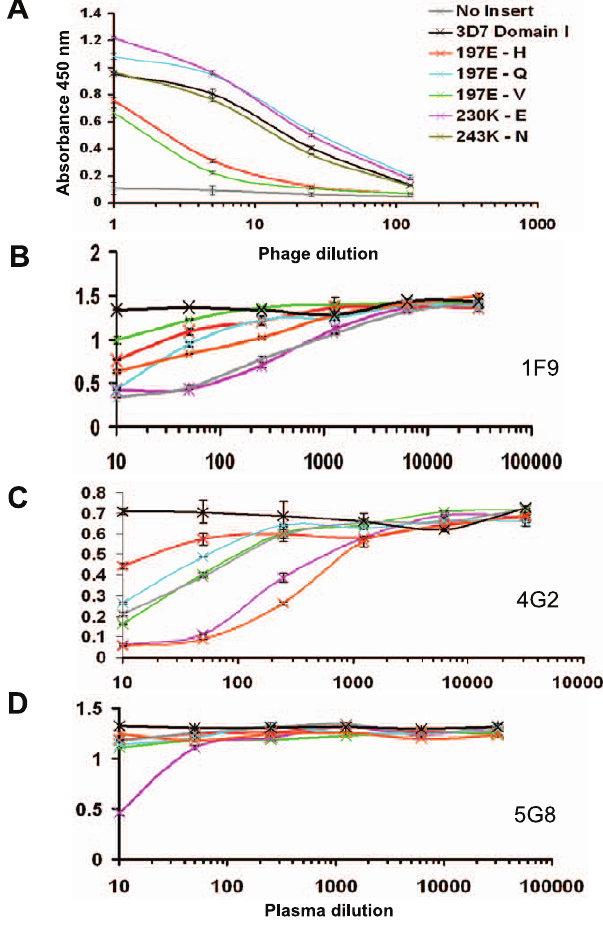
Figure 6. Binding of Human Plasma to AMA1 (A) Point mutations abrogate binding of AMA1 domain I to human antibodies. Phage expressing AMA1 domain I were tested for their ability to bind to immobilised AMA1-affinty purified human antibodies from a pool of Papua New Guinean blood donors. Control (black) is M13 phage expressing strain 3D7 AMA1 domain I. Negative control (grey) is phage expressing no insert. Point mutations tested were: residue 197E changed to (H red, Q cyan, V green), or residue 230 K-E (violet), or residue 243 K-N. Assays were carried out in duplicate and the error bars indicate the two measured absorbance values. (B–D) Individual human plasma compete for 1F9 binding to AMA1. Full- length 3D7 AMA1 ectodomain was immobilised on plastic. MAbs 1F9 (A), 4G2 (B), and 5G8 (C) were allowed to bind and the ability of a set of human plasma to compete for mAb binding was tested: plasma P8 (green), plasma P45 (pink), plasma P60 (red), plasma P69 (light blue), plasma P111 (orange), and plasma M157 (grey). Pooled plasma derived from a malaria unexposed individuals served as a negative control (black). Assays were carried out in duplicate and error bars indicate the two measured absorbance